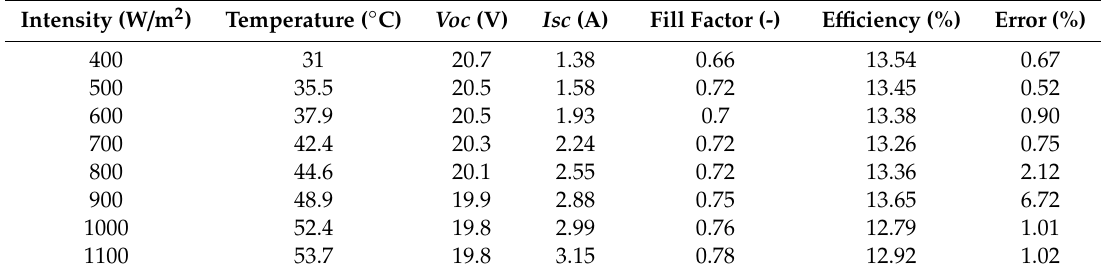
Table 5. Temperature and e ffi ciency of the solar cell with a 10-fin Cu-Cu heat